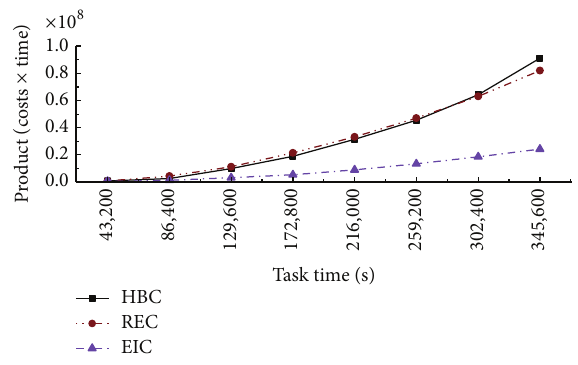
Figure 22: Comparison of combined metrics (product of total execution time and cost).